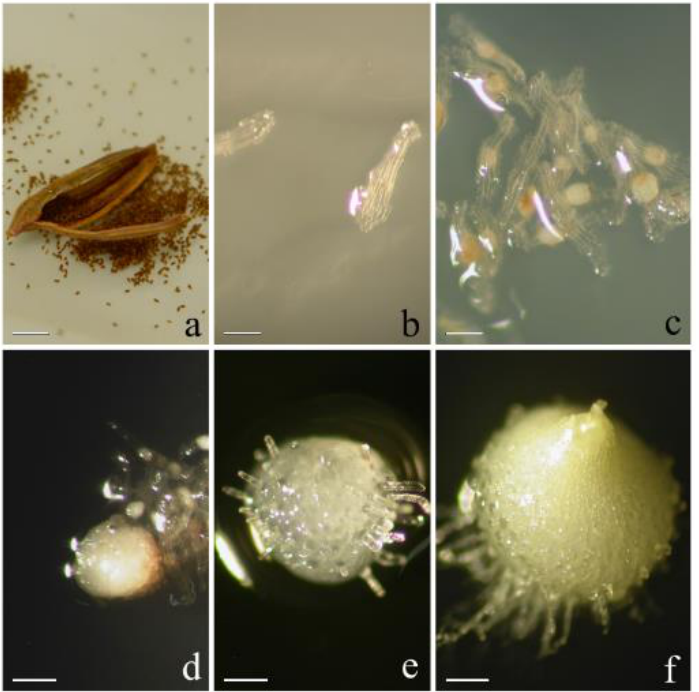
Figure 3. In vitro asymbiotic germination of Ophrys panormitana : ( a ) opened capsule of Ophrys panormitana ; ( b ) stage 0 ‘’no germination’’; ( c ) stage 1 ‘’pre-germination’’; ( d ) stage 2 ‘’germination’’; ( e ) stage 3 ‘’protocorms’’; ( f ) stage 4 ‘’appearance of protomeristem’’. Bars: 5 mm ( a ); 1 mm ( b , c ); 4 mm ( d – f ).